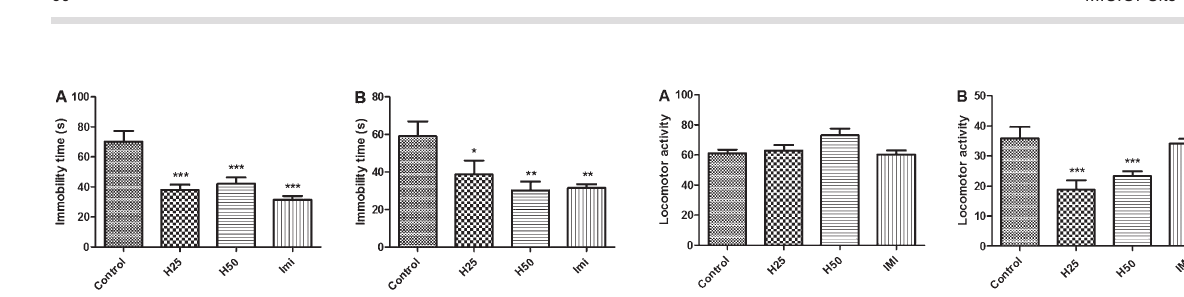
Figure 1. Immobility time in the forced swimming test of mice that received vehicle (control), Hoodia gordonii [25 mg/kg (H25) and 50 mg/kg (H50), po ] and imipramine (Imi, 10 mg/kg, ip ). Animals received H. gordonii acutely ( A ) and for 15 consecutive days ( B ). Results are reported as means±SE. *P , 0.05, **P , 0.01, ***P , 0.001, compared to control (ANOVA and Student- Newman-Keuls post hoc test).